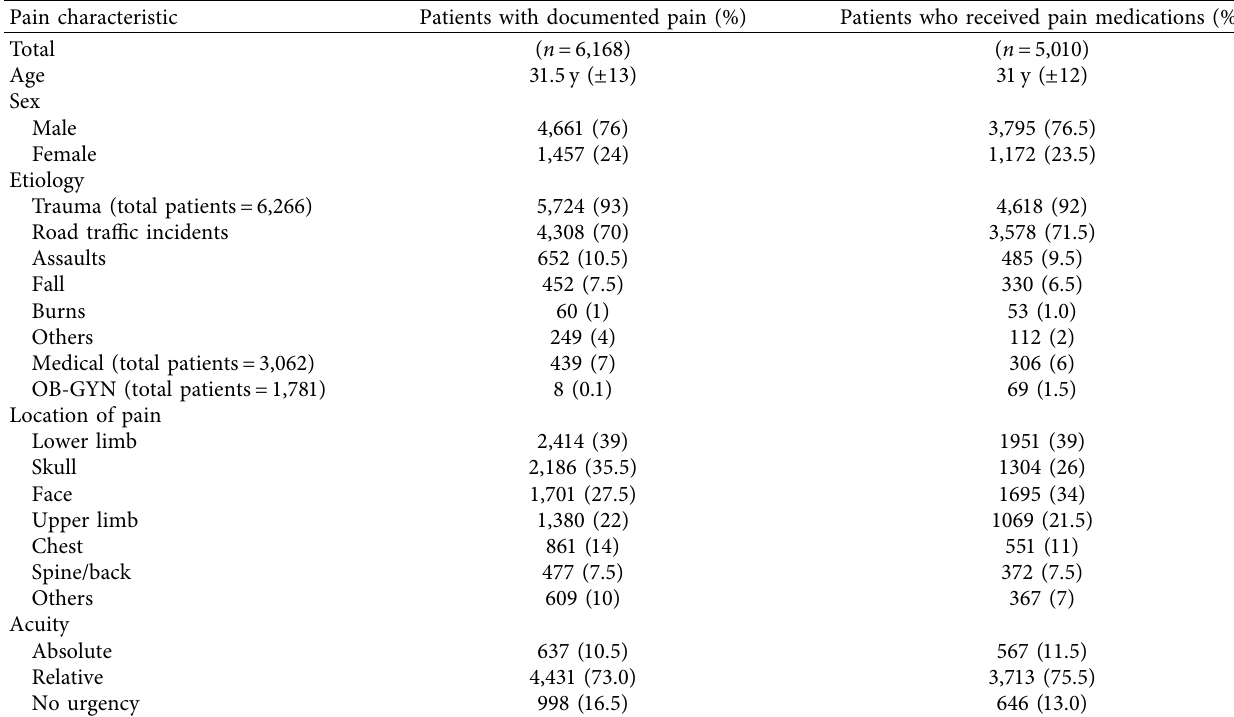
Table 1: Pain etiology and location by patients with documented pain and those who received pain